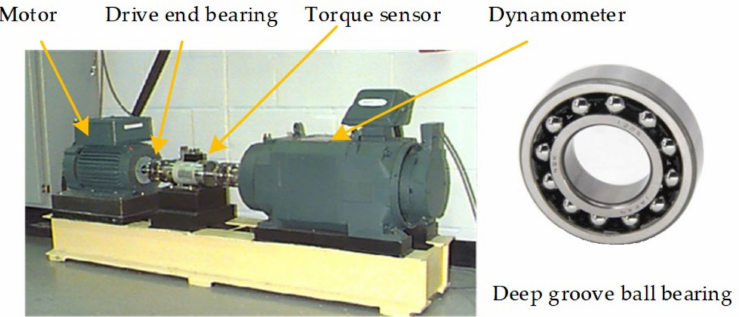
Figure 7. The CWRU data set experiment platform.